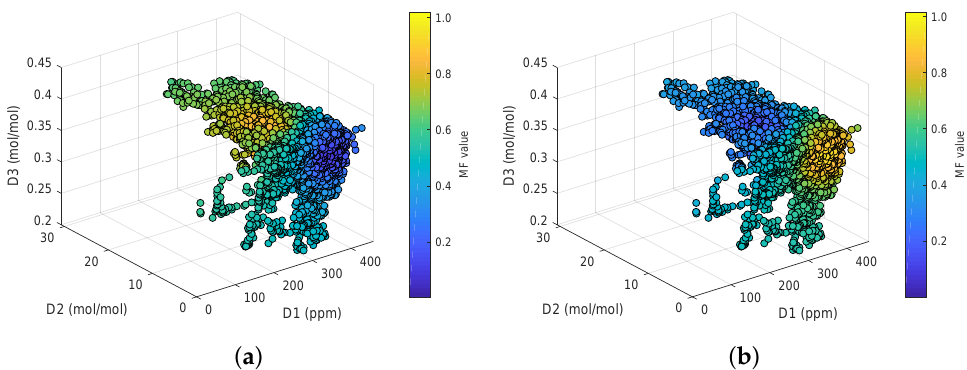
Figure 2. Performance of fuzzy C-means clustering: ( a ) Operating mode 1; ( b ) Operating mode 2 (main operating